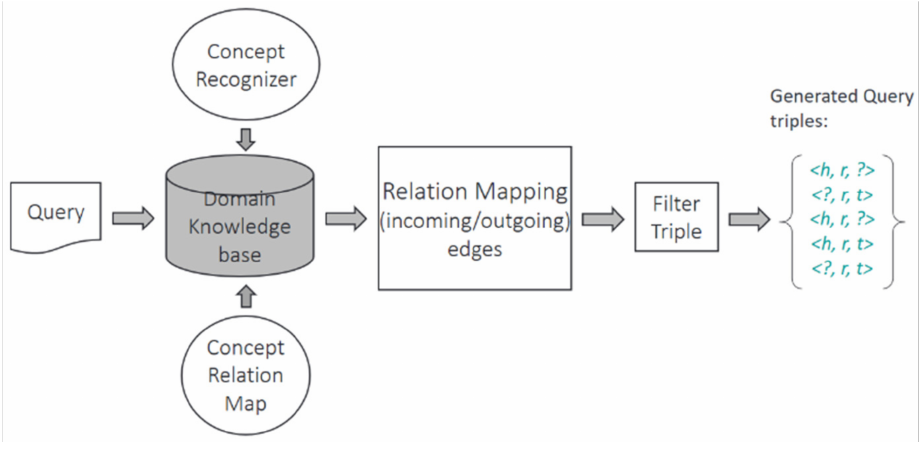
Figure 4. Triple generator